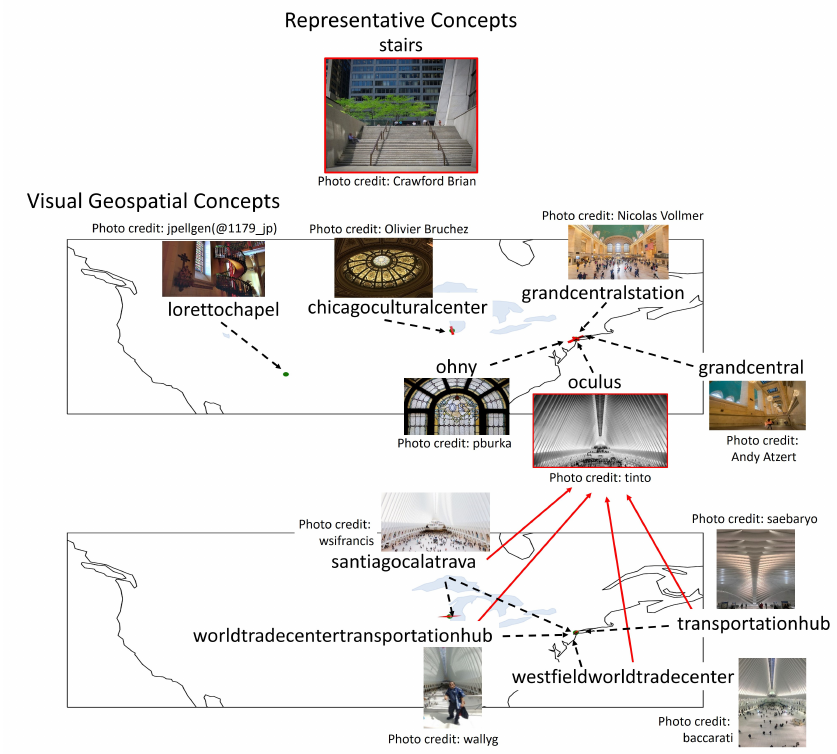
Figure 13. Examples of visual geospatial concepts represented by a visual concept stairs . The visual geospatial concepts themselves can also represent other visual geospatial concepts. The visual concept stairs represent the visual geospatial concepts shown in the middle layer: lorettochapel , chicagoculturalcenter , grandcentralstation , grandcentral , ohny , and oculus . oculus represents the visual geospatial concepts in the bottom layer. Only the edges among oculus and other visual geospatial concepts are presented for visual